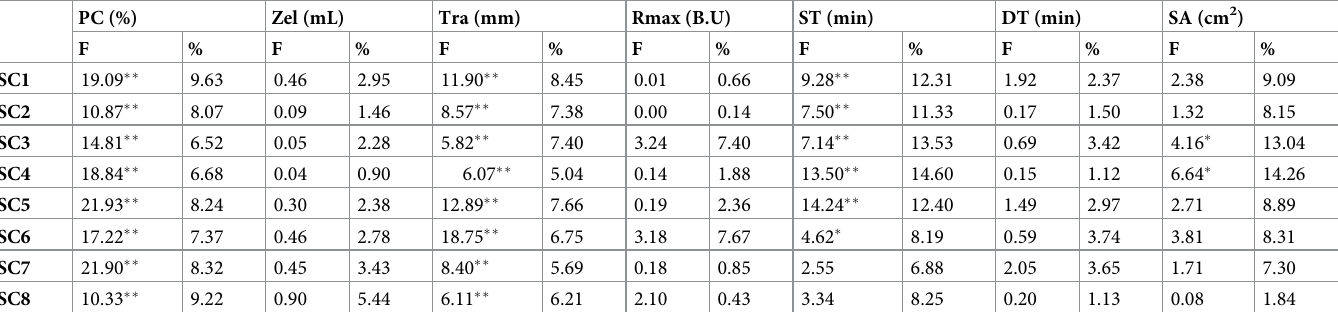
F is the test value of the analysis of variance between rain-fed and well-watered regimes. � and �� represent significant differences at the 0.05 and 0.01 levels, respectively. % represents percentage ranges to determine the effects of a change in the two water regimes on the value of each quality